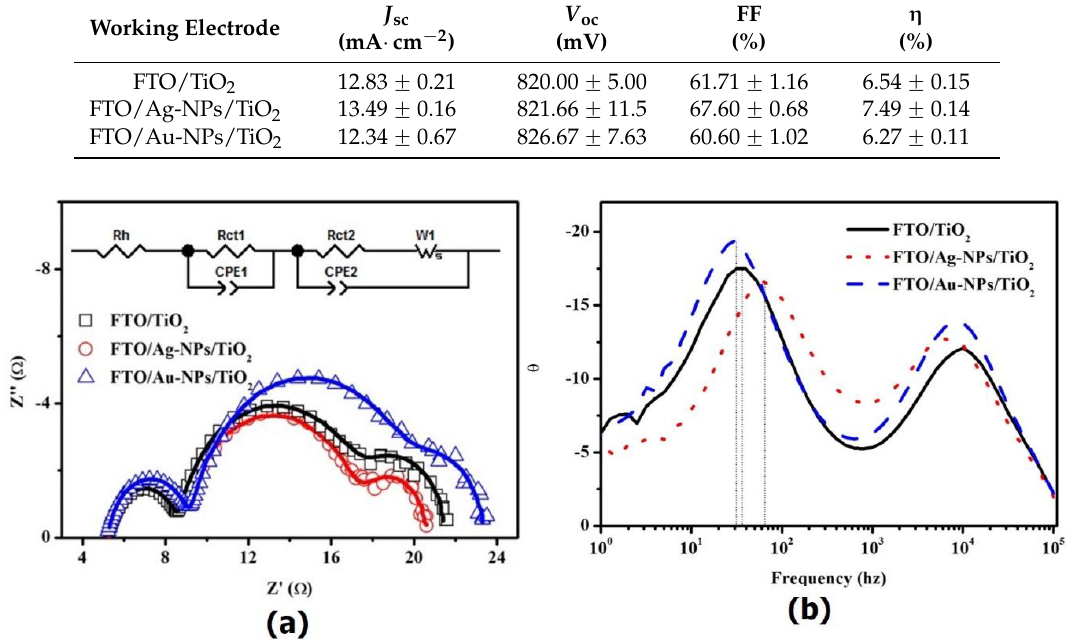
Figure 3. ( a ) Nyquist plots of three DSCs equipped with different working electrodes; and ( b ) The electrochemical impedance spectroscopy (EIS) Bode plots of three DSCs equipped with different working electrodes. Z’’: imaginary part of impedance; Z’: real part of impedance; CPE1: the constant phase element at counter electrode/electrolyte interface; CPE2: the constant phase element at working electrode/electrolyte interface; Rh: Ohmic internal resistance; Rct1: charge-transfer resistance at counter electrode/electrolyte interface; Rct2: charge-transfer resistance at working electrode/electrolyte interface; W1: Warburg impedance.